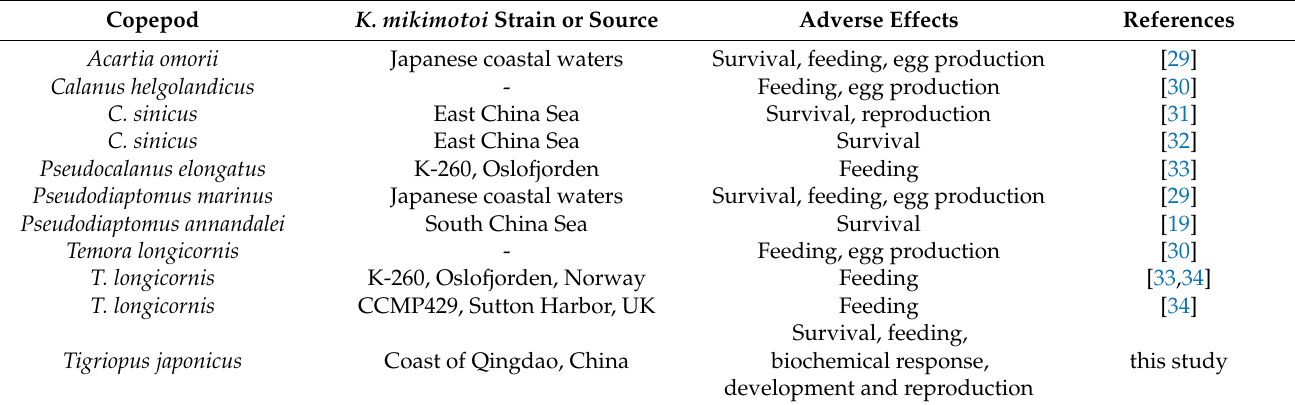
Table 1. Summary of studies revealing the adverse effects of K. mikimotoi on